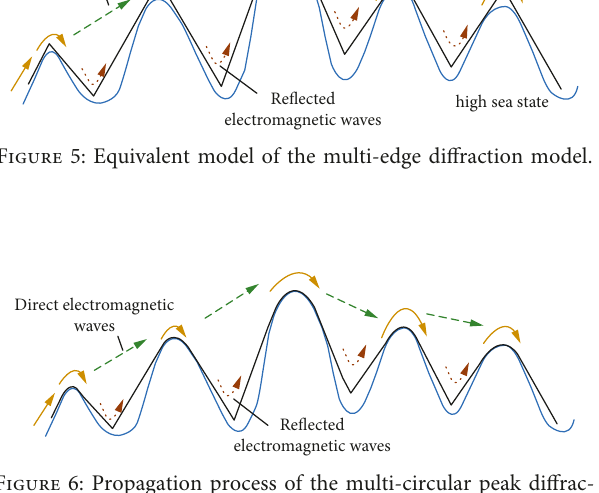
Figure 6: Propagation process of the multi-circular peak diffrac- tion model.